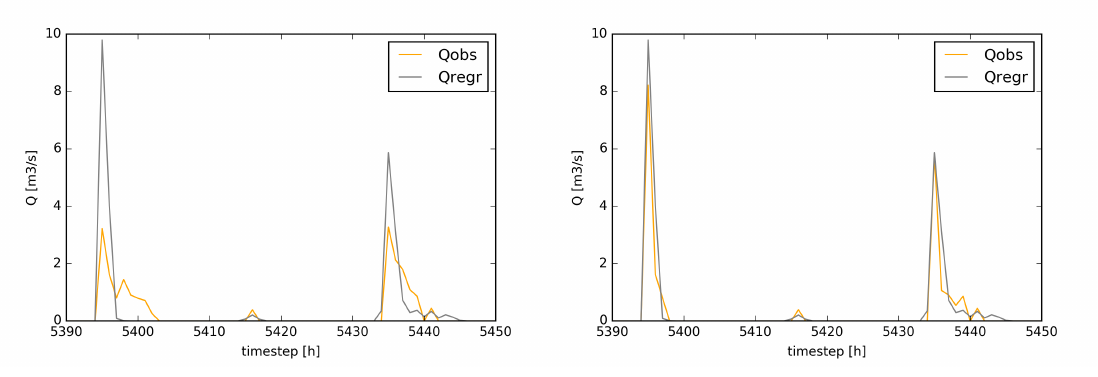
Figure 12. Observed (yellow) and regressed (grey) discharge at the outlet for bigger rainfall events in August 2015 with ( a ) reservoir occurrences and ( b ) adjusted reservoir